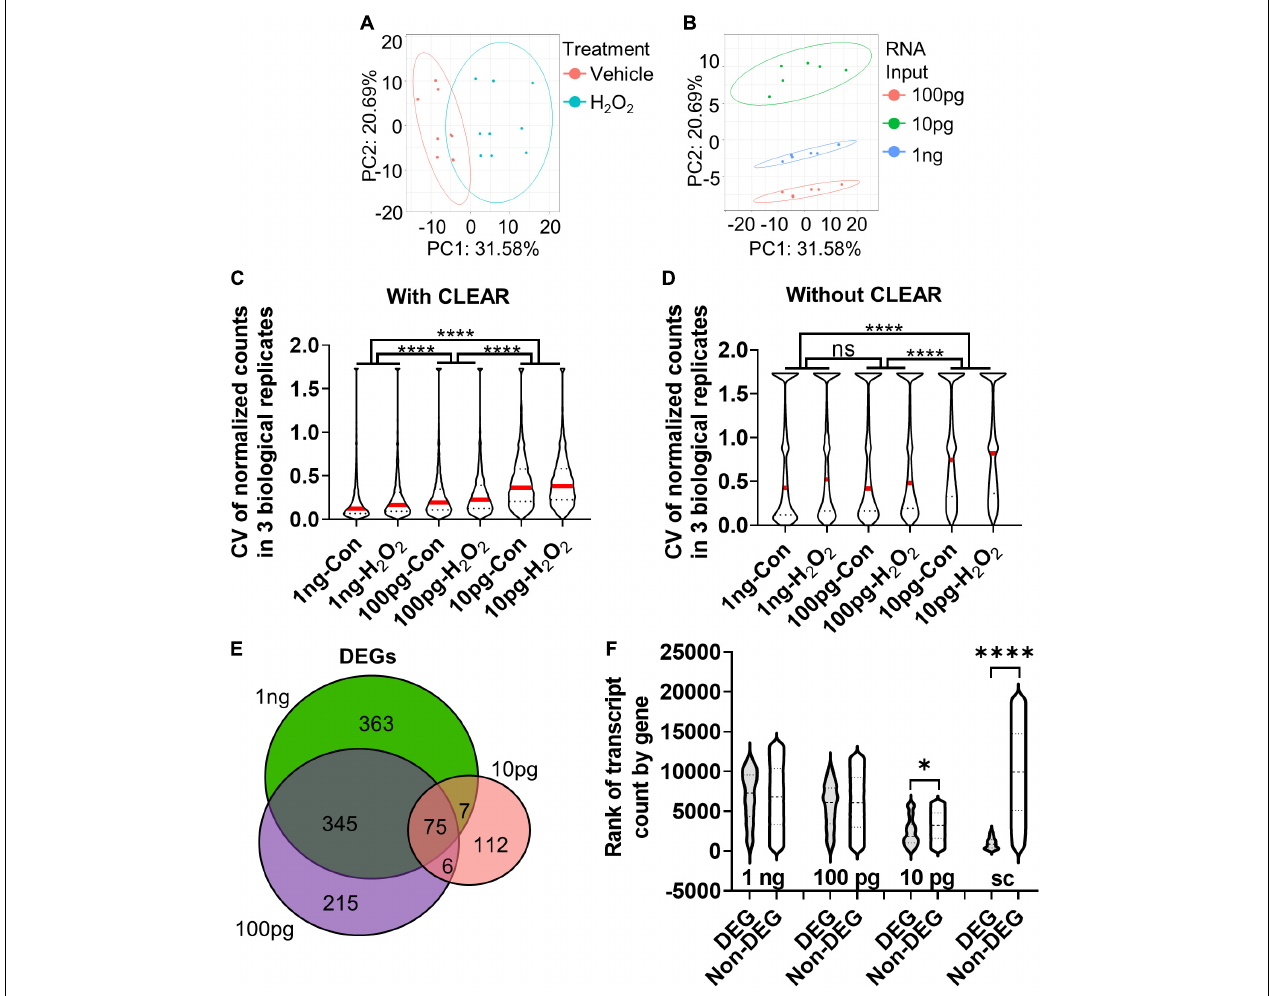
FIGURE 4 | Determination of optimal input RNA amount with RNAseq and CLEAR that preserves unbiased DEG identification. (A) PCA of cultured NSCs shows that cells undergoing oxidative stress diverge from control cells along principal component (PC) 1. (B) PCA of sample based on RNA input amount leads to significant separation between samples along PC2. (C) CVs were inversely related to RNA input amount. The difference in median CV between all RNA input levels were statistically significant. Median (red line) and quartiles (dotted lines) are shown within violin plots of CV for all genes detected in all samples. (D) Analysis of the CV with vehicle and H 2 O 2 -treated samples of all genes detected in all three RNA inputs before CLEAR filtering shows substantially greater CVs at all RNA input levels, confirming the utility of CLEAR preprocessing. Median (red line) and quartiles (dotted line) are shown within violin plots of CV for all genes detected in all samples. (E) Venn diagram of DEGs identified in all three RNA input levels show good overlap between 1 ng and 100 pg but poor overlap with 10 pg. (F) Comparison of ranked transcript counts for DEGs and Non-DEGs identified at the three different RNA input levels show no significant difference in transcript count rank